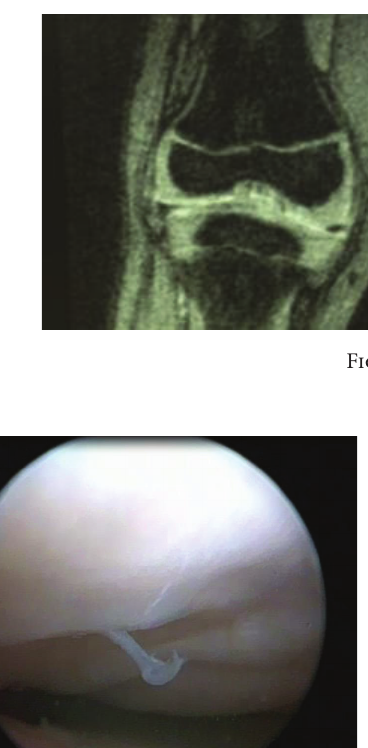
Figure 5: Arthroscopic view of right knee. Note the complete absence in the intercondylar notch of any structures of the central pivot.